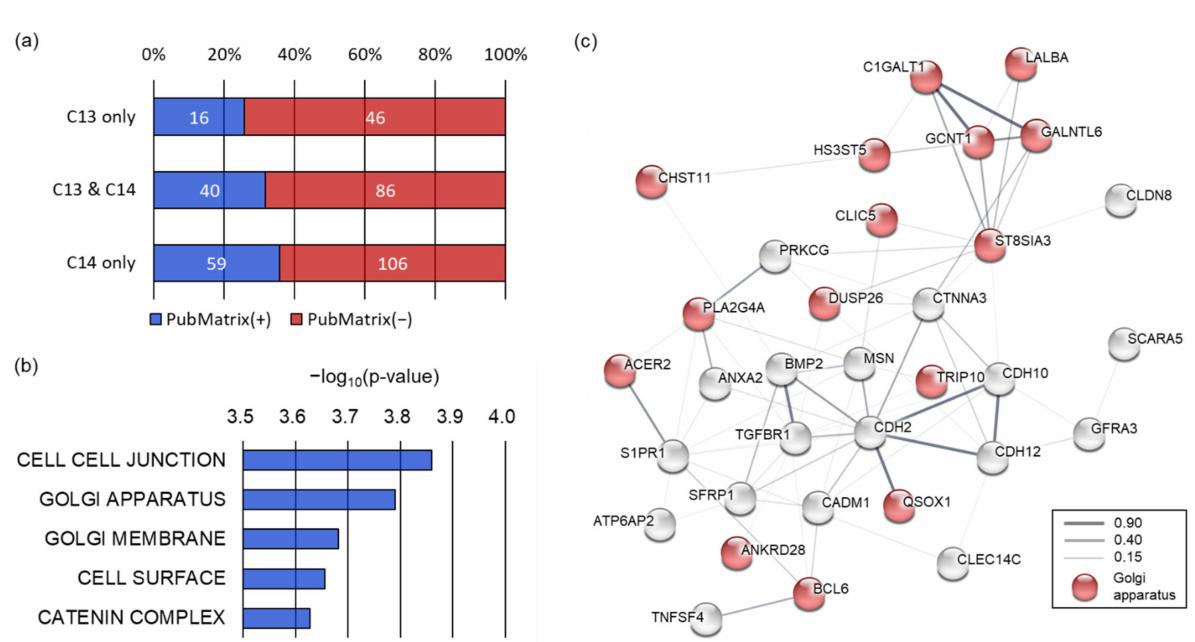
Figure 4. Golgi component affected by 8-oxoG in C14 sperm DNA. ( a ) Literature association of sperm genes containing 8-oxoG. Blue bars indicate the number of 8-oxoG genes with literature related to sperm (PubMatrix (+)) and red bars for genes without sperm-related literature (PubMatrix ( − )). The number in the bar represents the number of literatures related to sperm. ( b ) GSEA analysis of 8-oxoG genes exclusive to C14 sperm. Horizontal axis indicates ( − )log 10 -transformed p -value of each cellular component terminology. ( c ) Protein–protein interaction network analysis of functionally enriched 8-oxoG genes of C14 sperm. Nodes indicate the cellular component-enriched genes. Edge thickness indicates the interaction score. Red nodes represent the Golgi apparatus-enriched